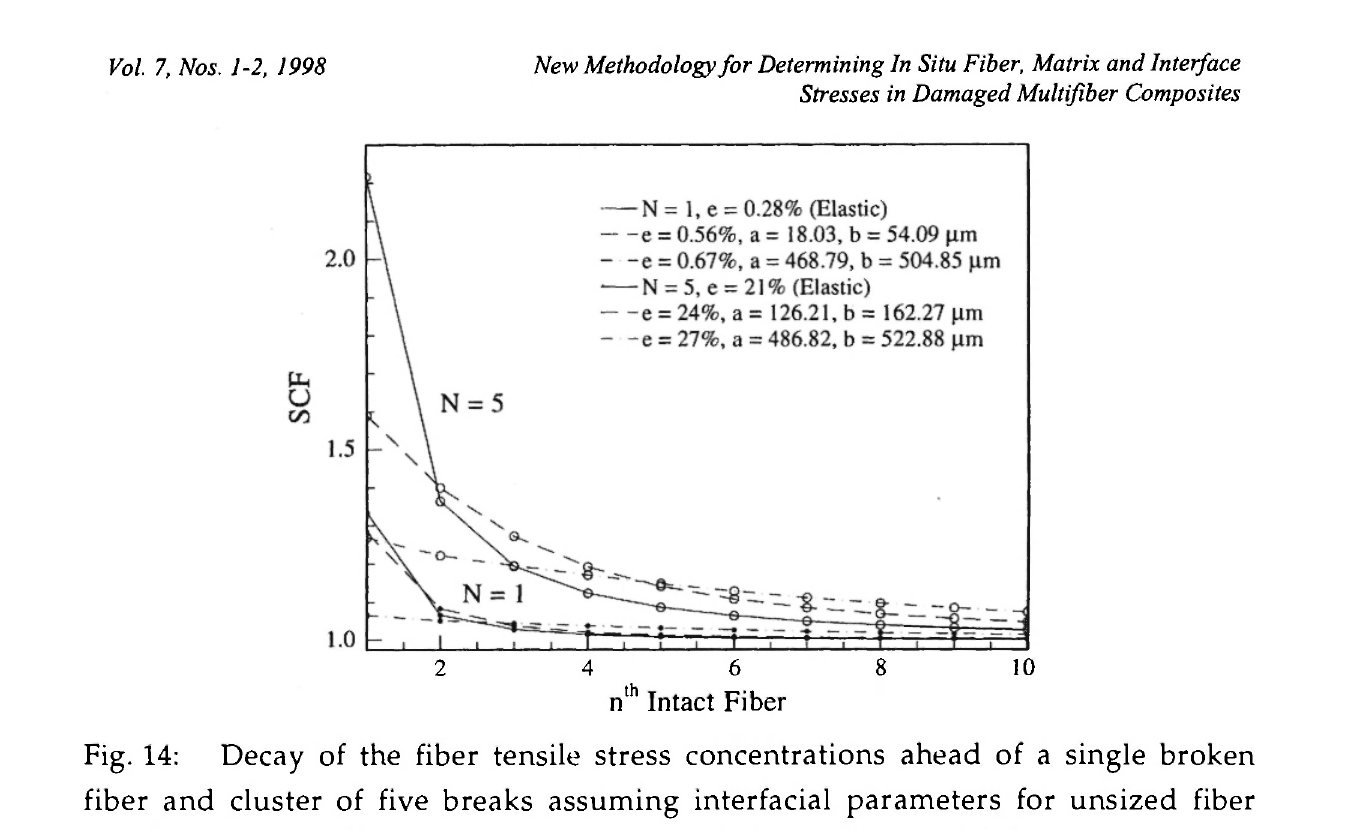
Fig. 14: Decay of the fiber tensile stress concentrations ahead of a single broken fiber and cluster of five breaks assuming interfacial parameters for unsized fiber composite with ζυ/h = 1.0 at an applied strain below interfacial damage initiation, and two